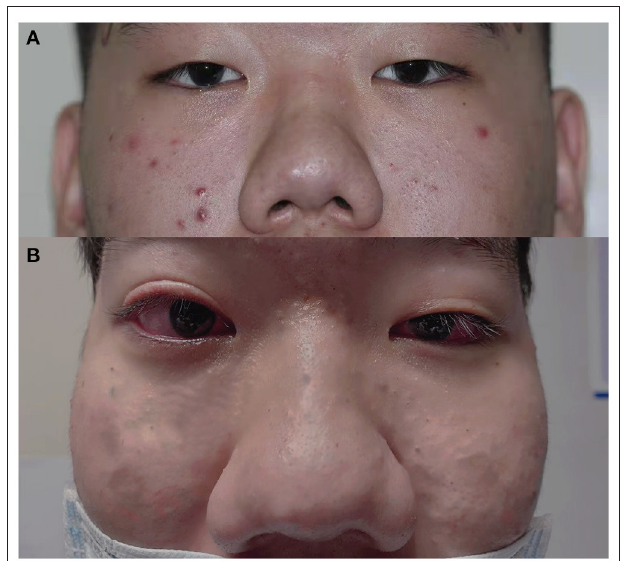
FIGURE 1 | General appearance of the patient. (A) : Facial hypertrophy and thickening of the nasal soft tissue can be seen since we first saw him till now. Bilateral mild ptosis before the blepharoptosis correction surgery 3 years ago. (B) : Mild ptosis still existed in OS, and incomplete eyelid closure existed in OD after the surgery.